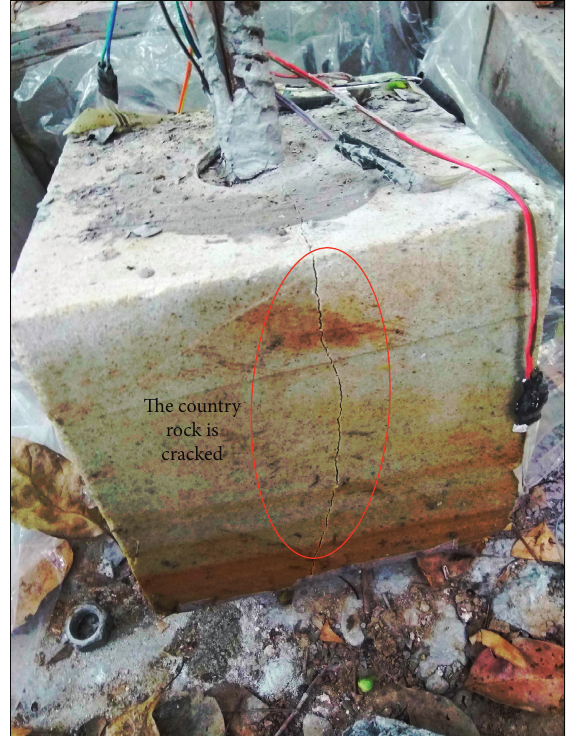
Figure 13: Sample rupture